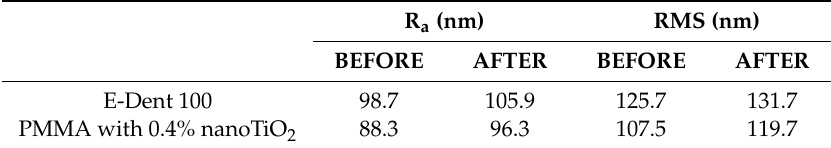
Table 3. Statistical quantities calculated for the 2D topography images (80 × 80 µ m and 90 × 90 µ m, respectively) recorded before and after performing the indentation